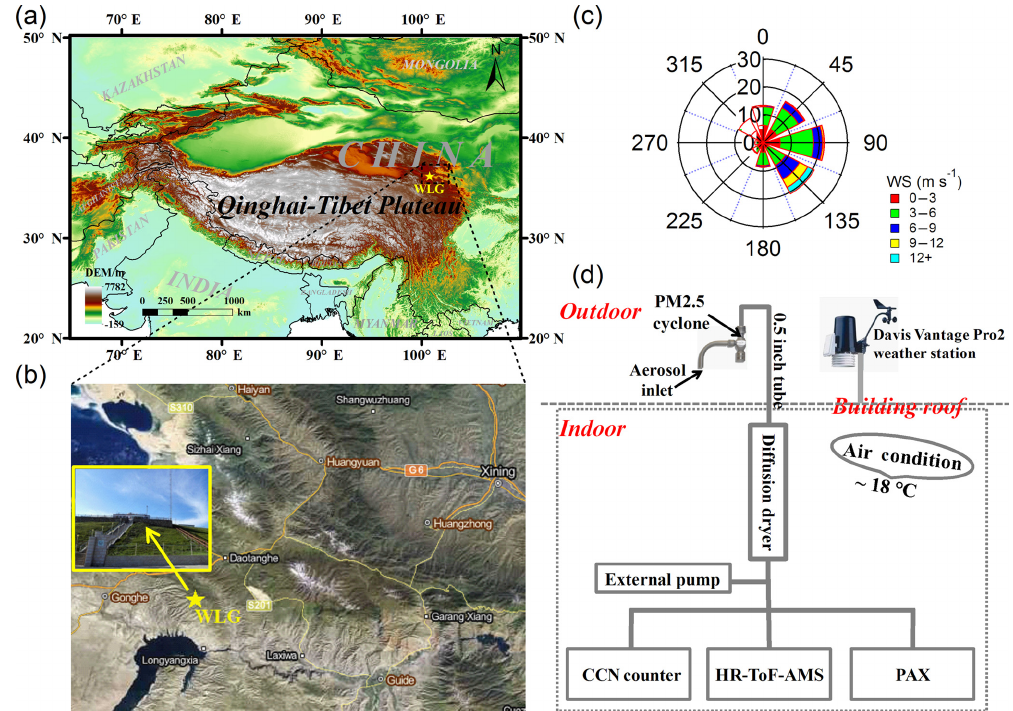
Figure 1. (a) Topography map of the Qinghai–Tibet Plateau (QTP), (b) location map of the Mt. Waliguan base (WLG; 36.283 ◦ N, 100.900 ◦ E; 3816m), (c) the wind rose plot colored by wind speed during the field study period and (d) the setup of instruments in this